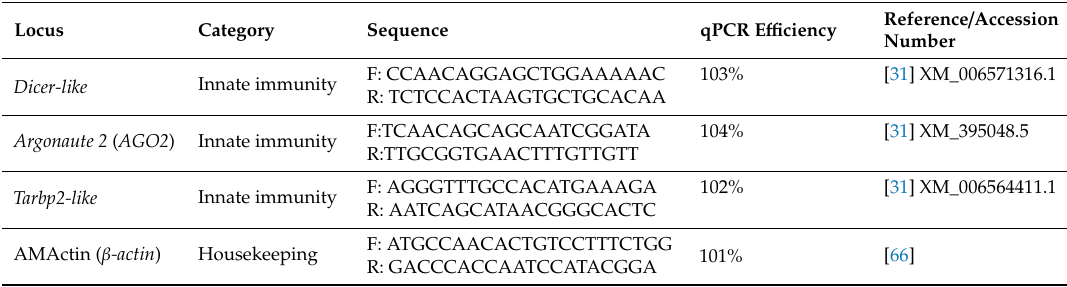
Table A2. List of primers used for quantification of transcripts in honey bees by reverse transcription followed by qPCR and e ffi ciency of